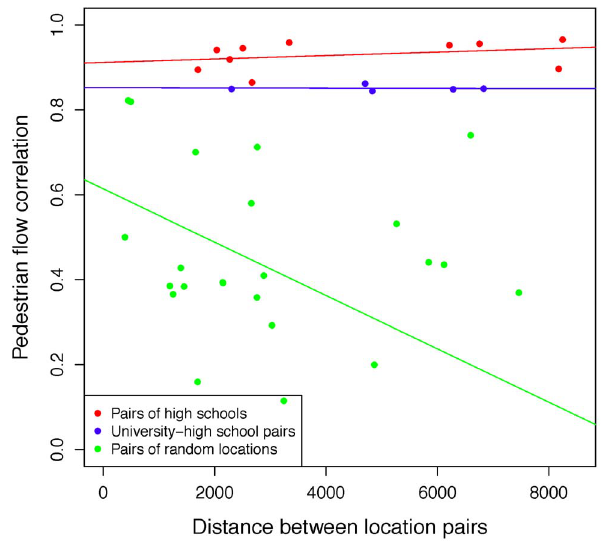
Figure 6. Distance affects pedestrian flow correlations. Corre- lation in pedestrian flows is affected by distance (in meters) between two locations. Orange dots are pairs of high schools, and blue dots are pairs consisting of the university and high schools. Green dots are pairs of semantically irrelevant locations. Regression lines are included with the colour of the respective category. We identify two trends in this data. With the green colour we show location pairs that are not semantically relevant, which demonstrate an inverse effect between distance and correlation of pedestrian volumes ( x random = – 6.285e-05, r 2 random =0.11, p random =0.007 ). In orange we show location pairs that are semantically relevant (pairs of high schools) and in blue we show location pairs that are highly related to each other (pairs consisting of the university and one high school). We find that for both sets of pairs distance has no significant effect on the pair’s correlation of pedestrian flows ( x university = – 2.647e-07, r 2 university = – 0.327, p university = 0.910; x highschools =4.075e-06, r 2 highschools =0.051, p highschools =0.172 ).